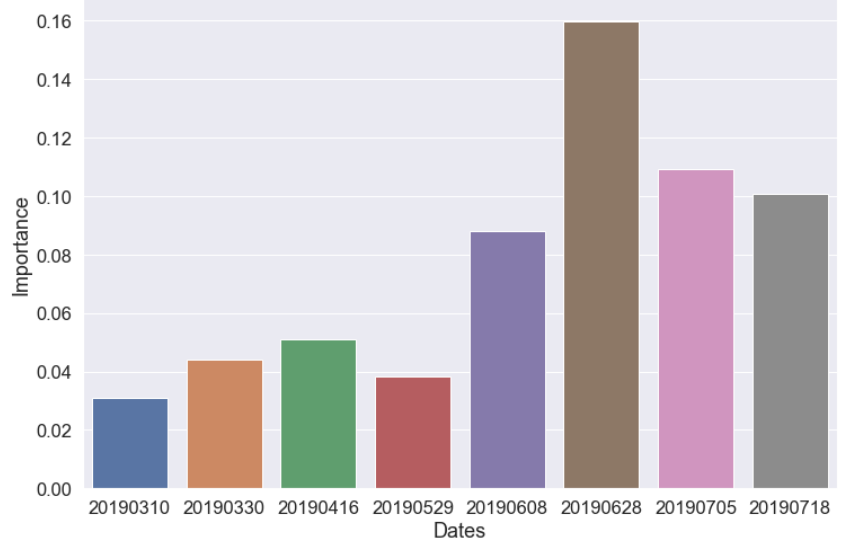
Figure 12. Relevance of time series